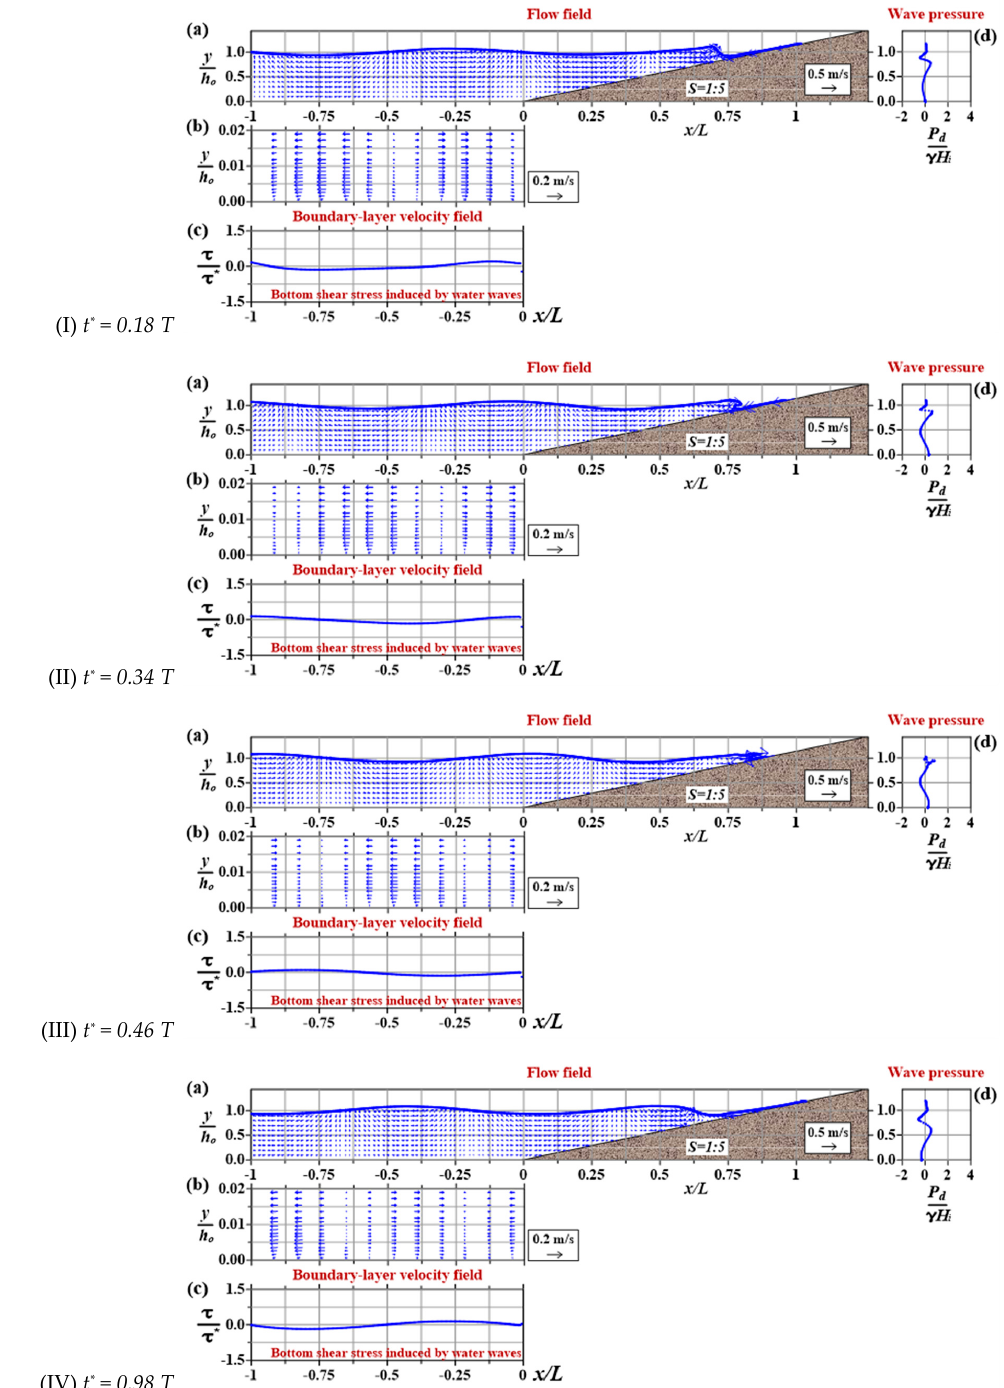
Figure 10. Snapshots of the periodic incident wave ( Ur = 4.7) propagation on a steep seawall with a slope of 1:5. ( a ) The free − surface and flow field velocity; ( b ) the boundary − layer flow; ( c ) the bottom shear stress prior to the seawalls; ( d ) the wave pressure on the seawall.